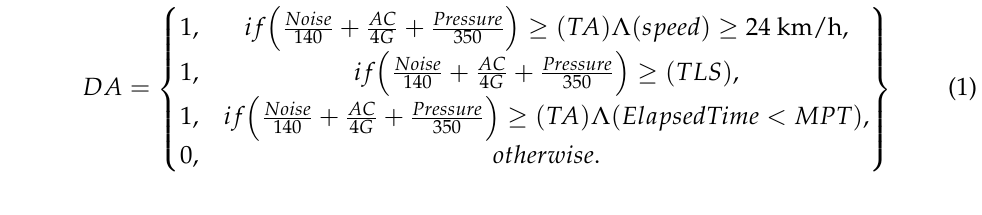
Algorithm 1: Accident